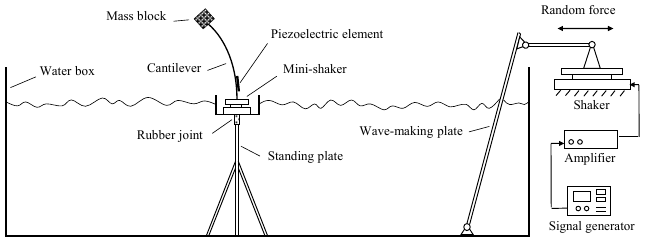
Figure 1. The diagram of experimental settings of bistable vibration power generation system in random wave environment.